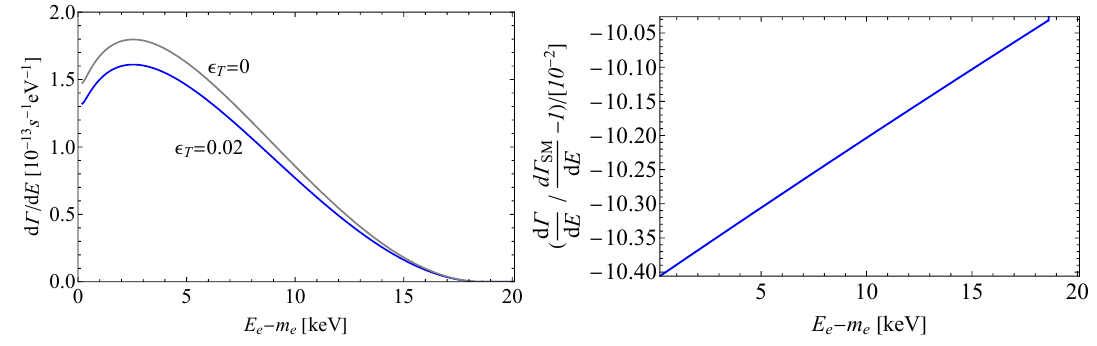
Figure 3 . Left: electron energy distribution, in terms of the electron kinetic energy, in the SM ( (cid:15) T = 0 ) and with a left-handed tensor current, (cid:15) T = 0 . 02 . Right: relative deviation between the two